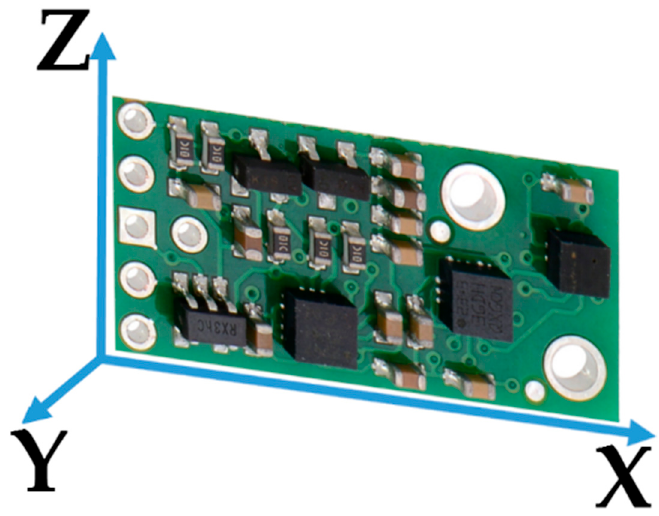
Figure 2. Accelerometer x -, y - and z -axis orientation.